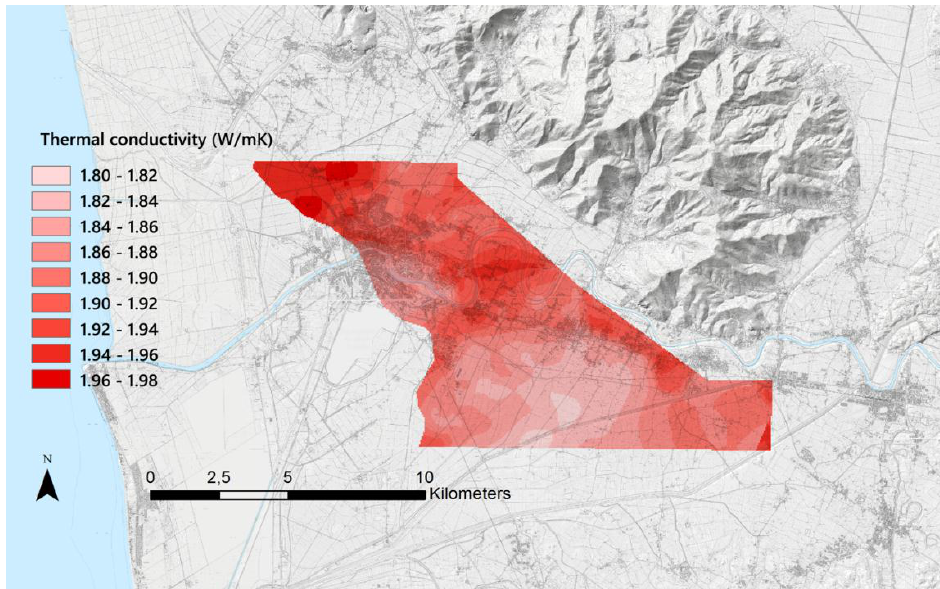
Figure 14. Thermal conductivity map (W m -1 ·K –1 ), weighed average over 100 m depth.